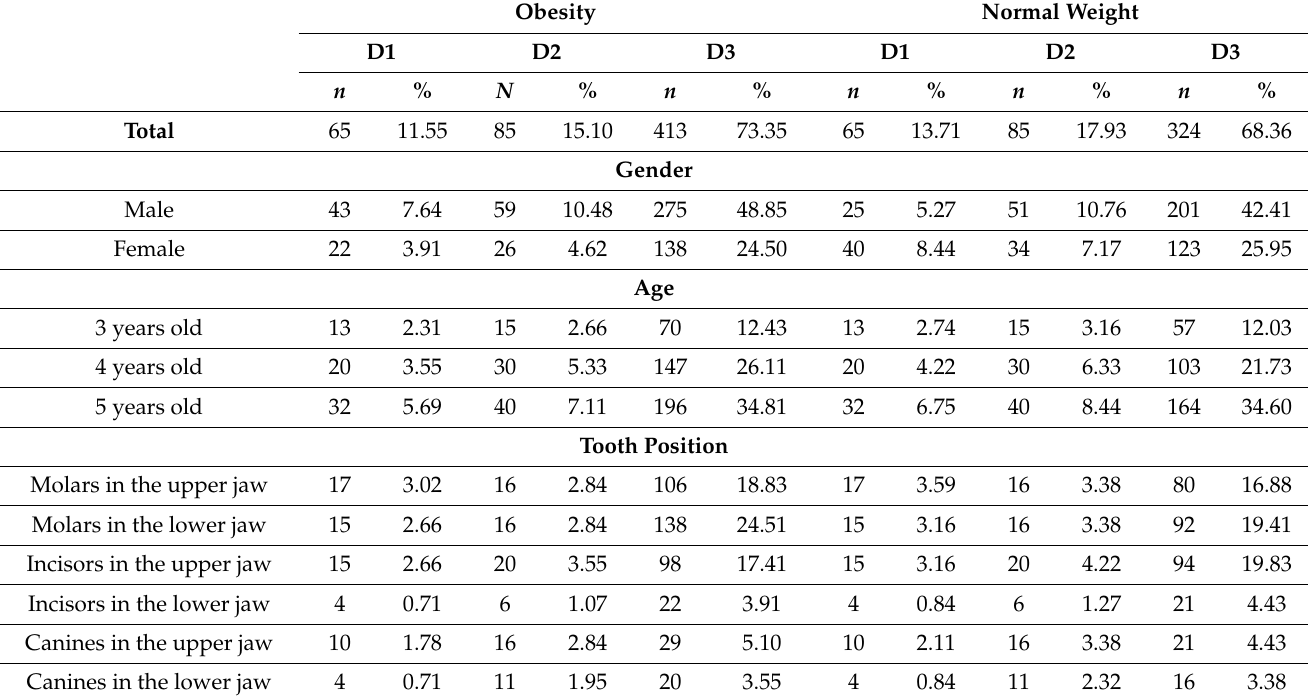
Table 2. Dental caries characteristics of research